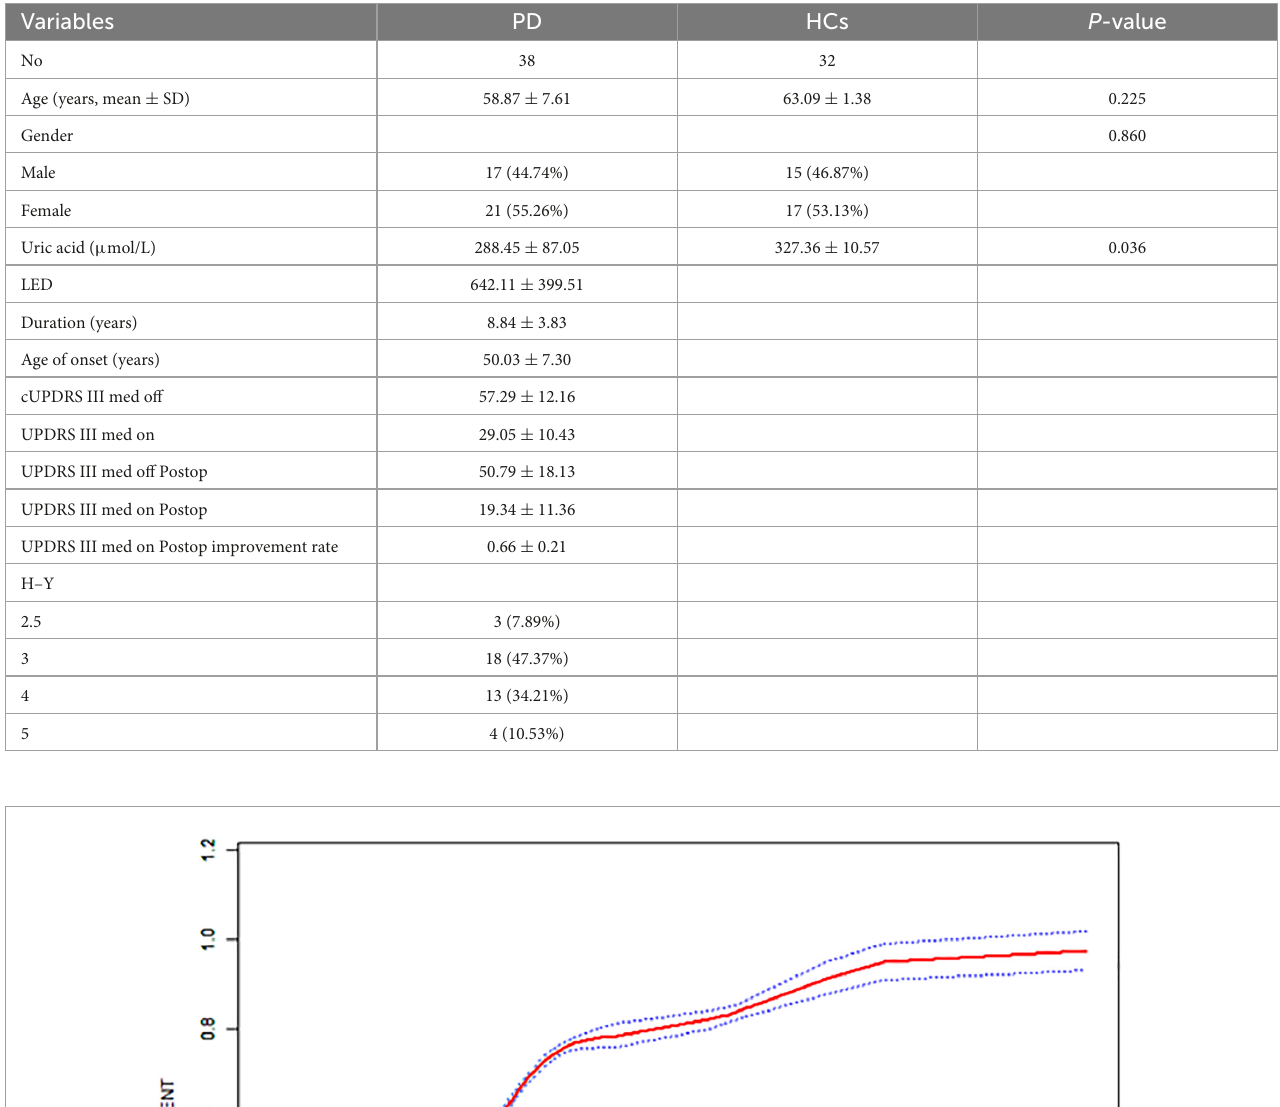
TABLE 1 Characteristics of the patients with Parkinson’s disease (PD) and healthy controls (HC).